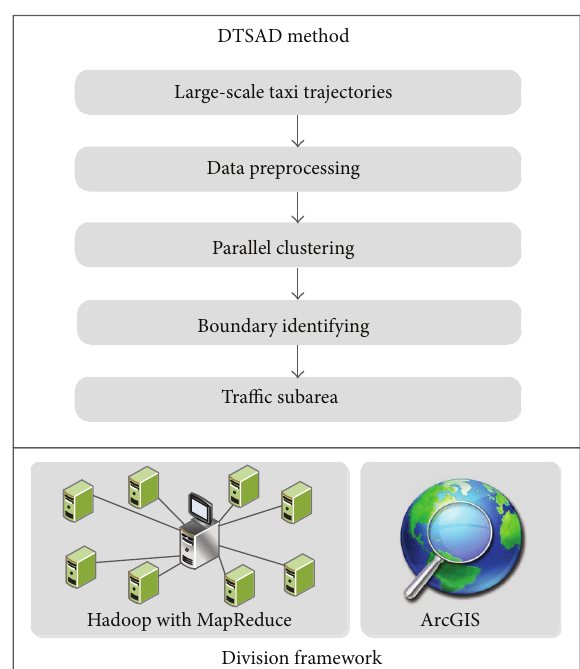
Figure 6: Process of the Par3PKM